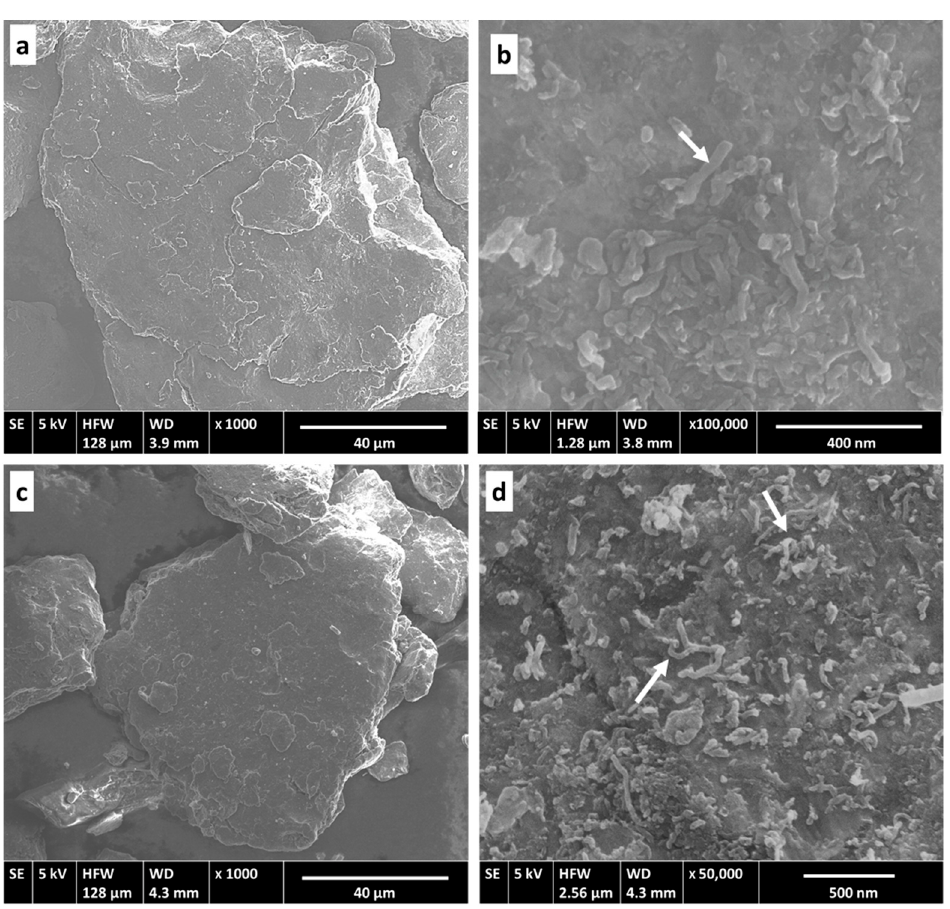
Figure 11. SEM micrographs of 7075-MWCNT composite powders after the completion of the H + H + LEBM strategy: ( a , b ) 0.5 wt.% MWCNTs; ( c , d ) 1 wt.% LEBM strategy: ( a , b ) 0.5 wt.% MWCNTs; ( c , d ) 1 wt.% MWCNTs.